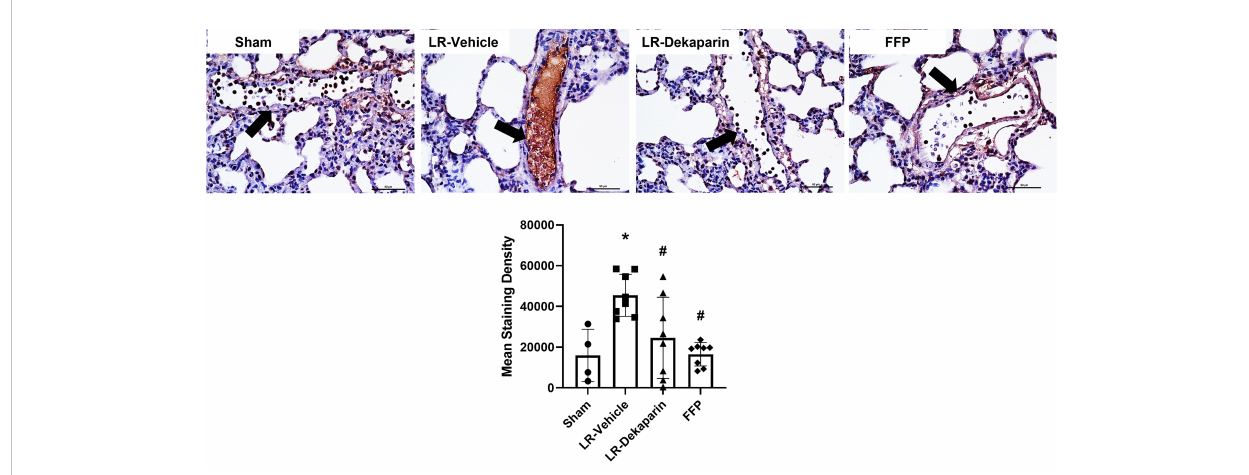
FIGURE 6 Dekaparin reduces T/HS-associated intravascular fi brin deposition. Lung tissue was collected after 3HR for immunohistochemical staining with anti- fi brin antibodies. Representative images (40x) images are provided. Three images were taken of each tissue and staining density quanti fi ed using NIS Elements software by a technician blinded to treatment group. Data are expressed as mean with standard deviation. N=4 Sham, N=8 LR-vehicle, N=8 LR-Dekaparin, N=8 FFP. Arrows indicate blood vessels. Scale bar denoted 50 m m. * denotes p<0.05 compared to sham. # denotes p<0.05 compared to LR-vehicle. LR, Lactated Ringer's; FFP, fresh frozen plasma; T/HS, trauma and hemorrhagic shock; 3HR, 3 hours after